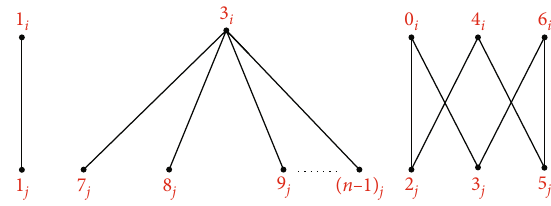
i , j : ∪ C ∪ K 1,1 6 1, n − 7 Þ